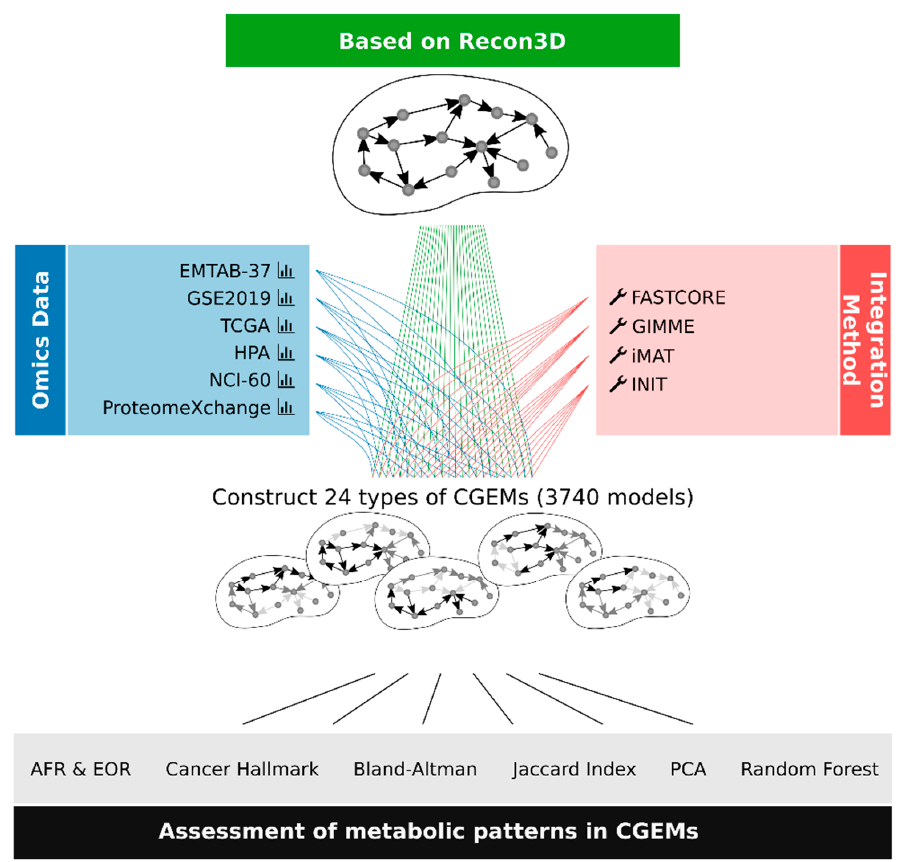
Figure 2. The workflow of the six different integrated human cancer omics datasets into GEM using four integration approaches. We generated 24 types of dataset–algorithm CGEMs. Afterwards, we evaluated the CGEMs by three indices (AFR, EOR, and cancer gene set). Using FBA, we calculated metabolic flux states for all CGEMs and then utilized different statistical and machine learning approaches to find the main metabolic features of CGEMs.